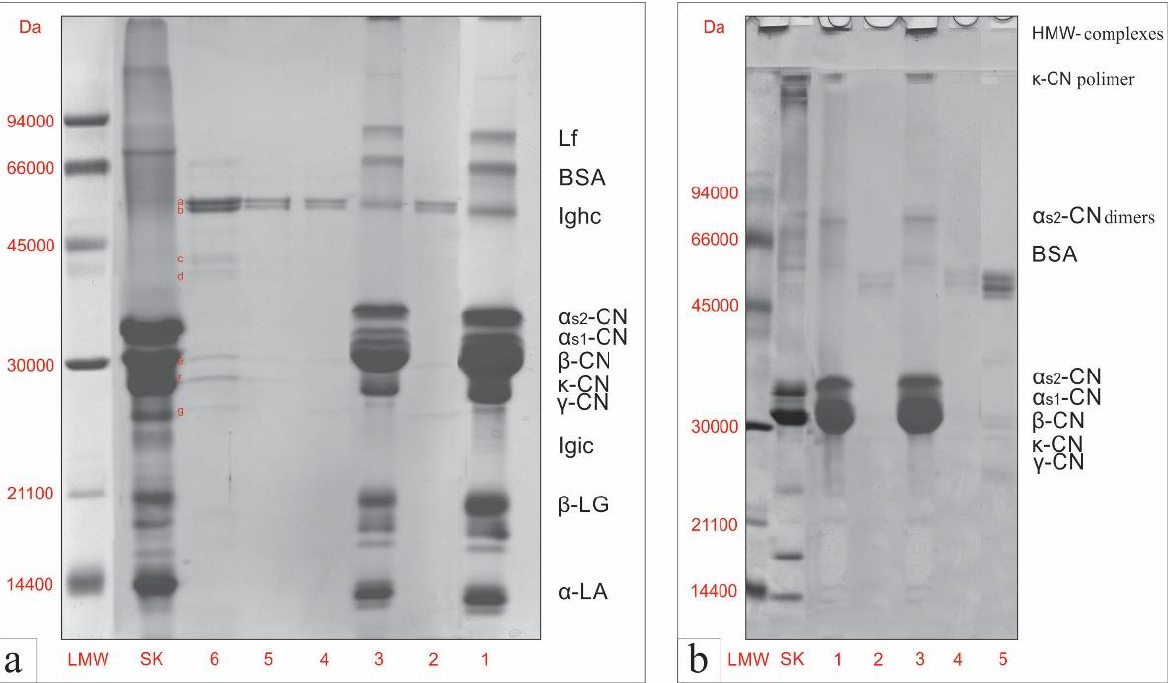
Figure 1. Electrophoretic patterns of TM and TME samples before and after in vitro gastrointestinal digestion, analyzed by SDS-R-PAGE ( a ) and SDS-NR-PAGE ( b ). Samples: TM — undigested heat- treated skim goat-milk powder (1); DTM — digested heat-treated skim goat-milk powder (2); TME — undigested heat-treated skim goat-milk/seed-extract powder (3); DTME — digested heat-treated skim goat-milk/seed-extract powder (4); digestive cocktail control, (25µL loaded into the well) (5); digestive cocktail control, (100 µ L loaded into the well) (6); a,b,c,d,e,f,g—bands originating from enzymes. Abbreviations: molecular weight standard (LMW); bovine milk-protein standard (SK); lactoferrin (Lf); bovine serum albumin (BSA); immunoglobulin hard chain (Ighc); α s2-casein ( α s2- CN); α s1-casein ( α s1-CN); β -casein ( β -CN), κ -casein ( κ -CN); γ -casein ( γ -CN); α -lactalbumin ( α -LA); β -lactoglobulins ( β -LG).